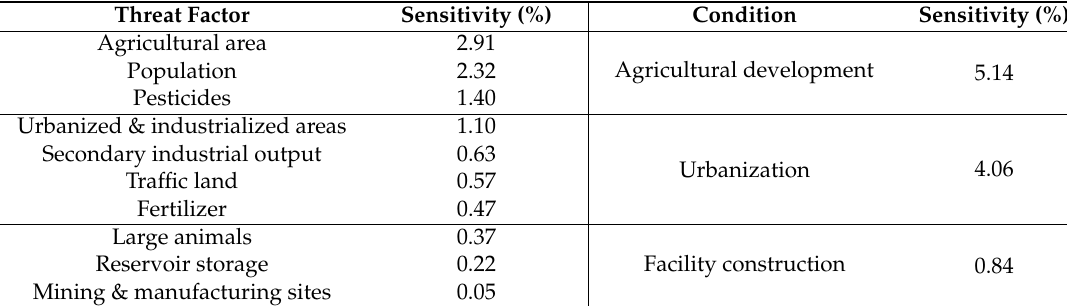
Table 3. Sensitivity in a positive direction of individual factors and under different conditions listed in descending